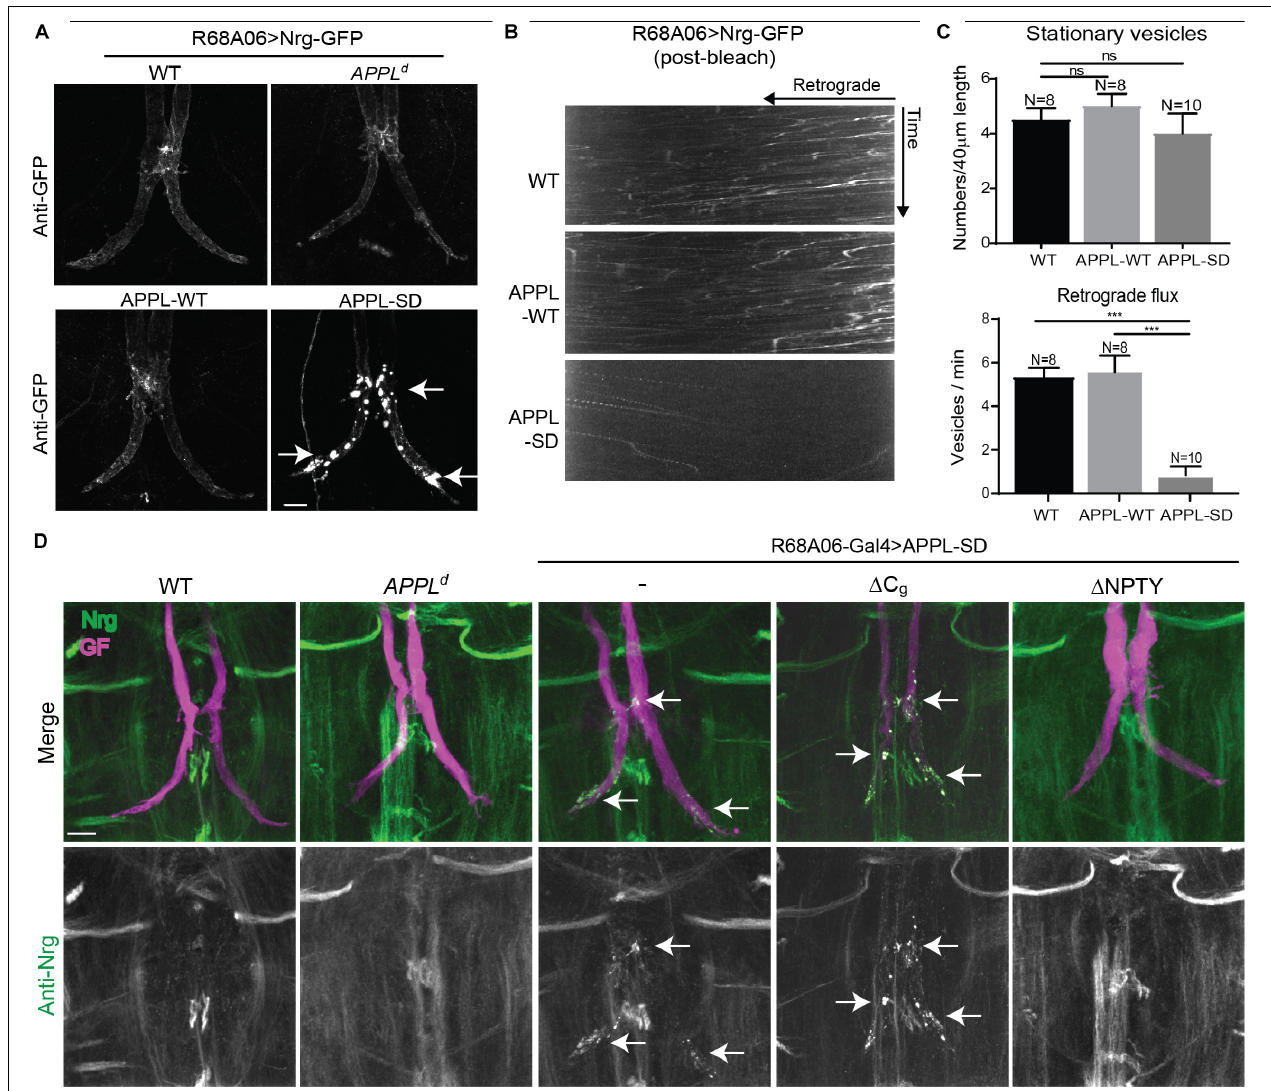
FIGURE 5 | Nrg localization and trafficking in GF terminal of APPL gain and loss of function mutants. (A) Nrg-GFP was conditionally expressed in GFs of wildtype and in APPL d null mutants with the R68A06 Gal4-line as well as co-expressed with wildtype (APPL-WT) and secretion-deficient (APPL-SD) APPL after GF synapse formation. Nrg accumulations in GF terminals are indicated by arrows. Scale bar represents 10 µ m. (B) Kymographs of axonal transport of Nrg-GFP vesicles in wildtype (WT) control animals and when co-expressed with APPL-WT or APPL-SD using R68A06 Gal4-line ( Supplementary Videos S8 – S10 ). (C) Quantification of Nrg-GFP vesicle trafficking in wildtype background as well as when co-expressed with APPL-WT and APPL-SD. Numbers of stationary vesicles, and numbers of vesicles moving in retrograde direction (Flux) were analyzed. N indicates numbers of axons assessed. Error bars represents standard error mean. Statistical significance between genotypes was assessed using Student’s t -test (ns, non-significant, p > 0.05, ∗∗∗ p < 0.001). (D) Localization of endogenous Nrg (green) labeled by an antibody against the intracellular domain of Nrg in wildtype and in APPL d null mutants as well as when with APPL-WT, APPL-SD, APPL-SD- (cid:49) Cg, and, APPL-SD- (cid:49) NPTY were expressed in GFs with the R68A06 Gal4-line. GFs were labeled by dye injections of rhodamine-dextran (magenta) into the GF axons. Nrg accumulations in GF terminals are indicated by arrows. Scale bar represents 10 µ